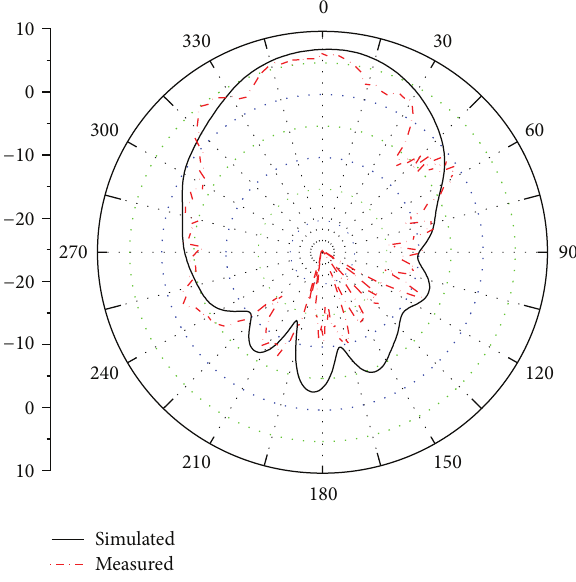
Figure 13: E-plane radiation pattern at 35